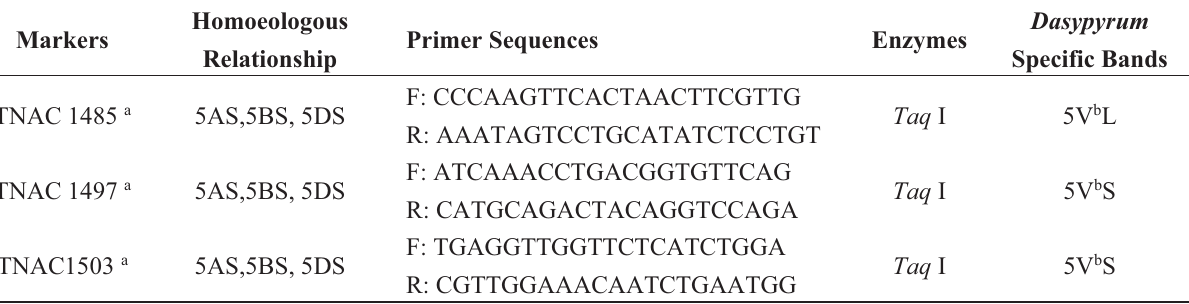
Table 1. The PCR primers used in this